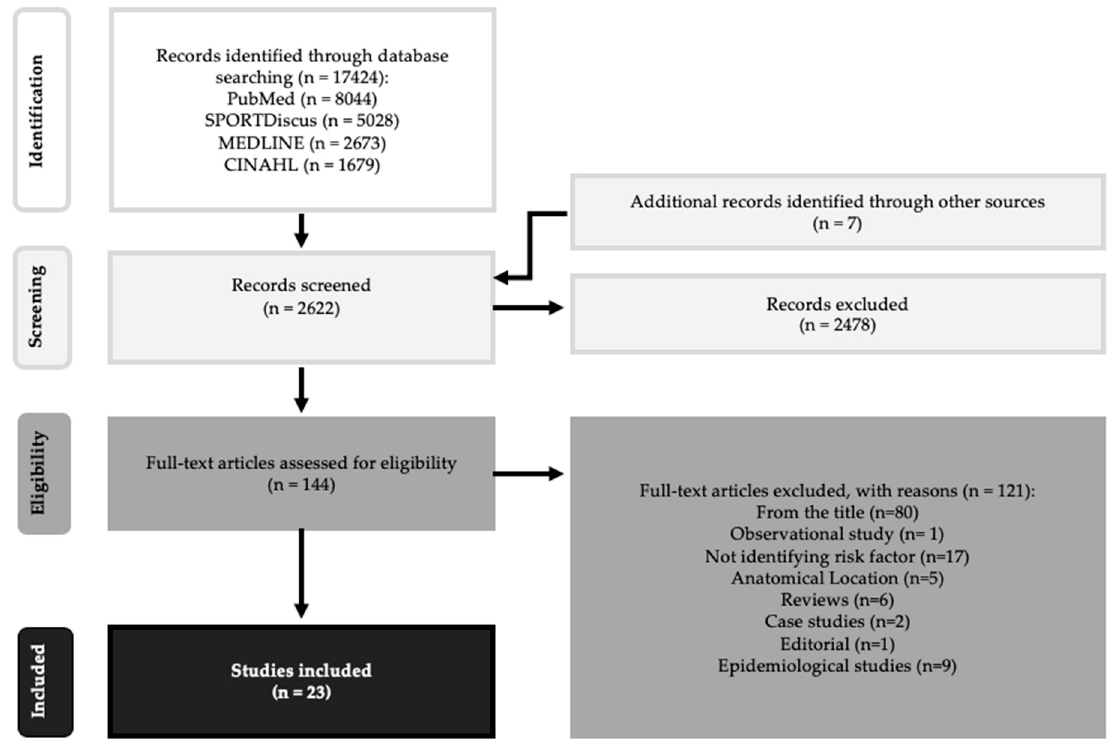
Figure 1. Flow chart of the selection process according to PRISMA statement [15].